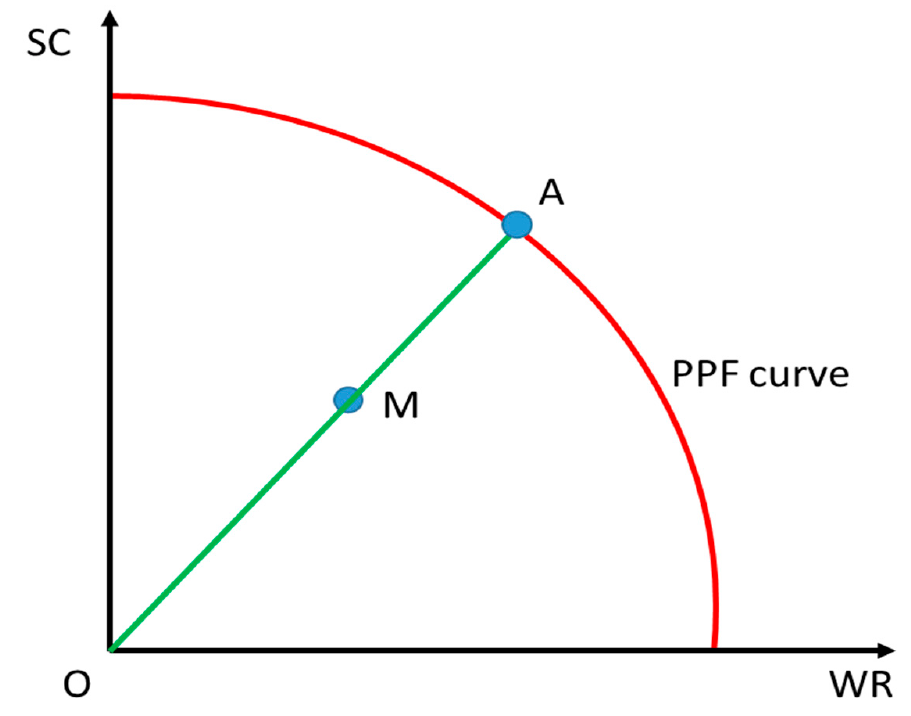
Figure 2. The schematic diagram for the calculation of trade-off intensity.